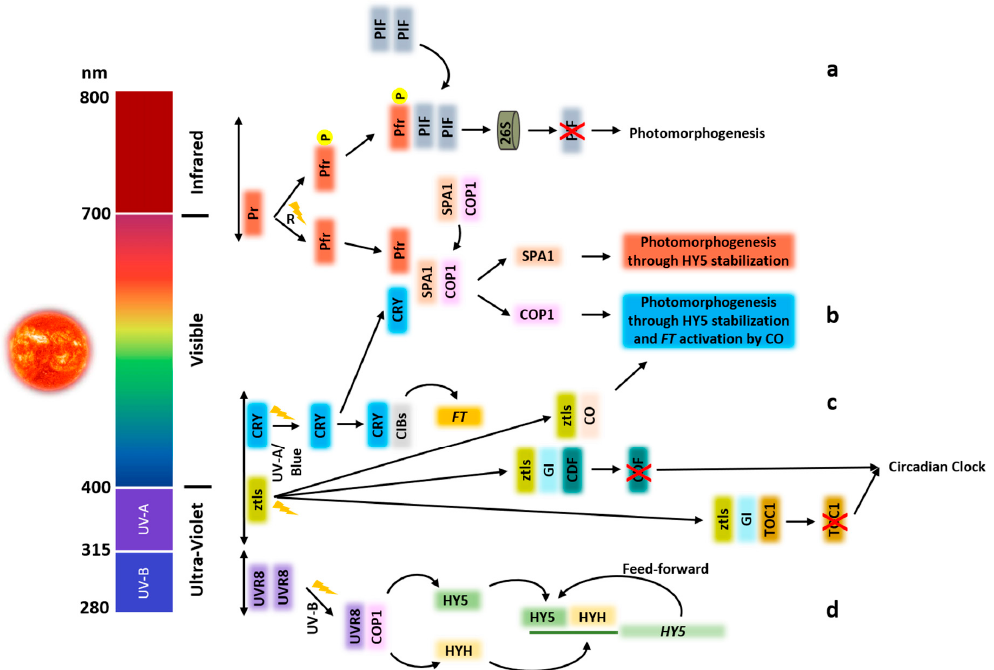
Figure 1. Proposed explanatory model of plants photoreceptors activity upon activation by light. ( a ) The biological active Pfr form of the phytochrome is activated by red light (R). The